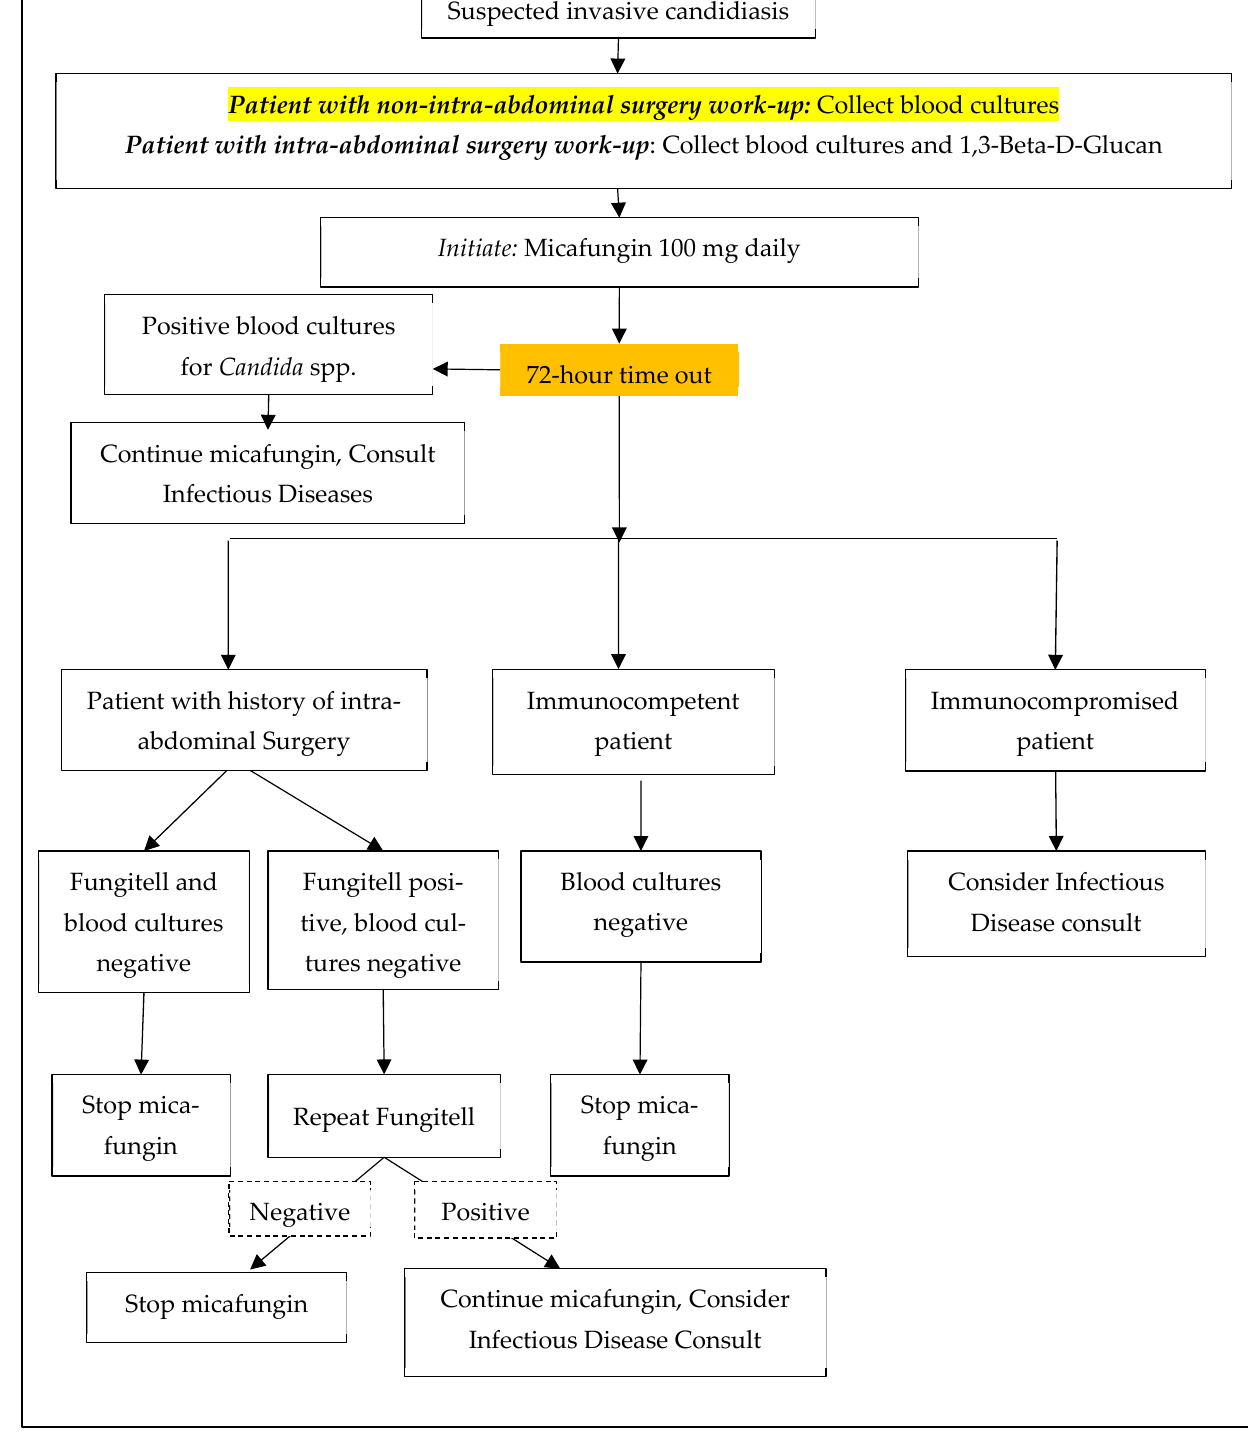
Figure 2. Micafungin Antifungal Stewardship Algorithm.